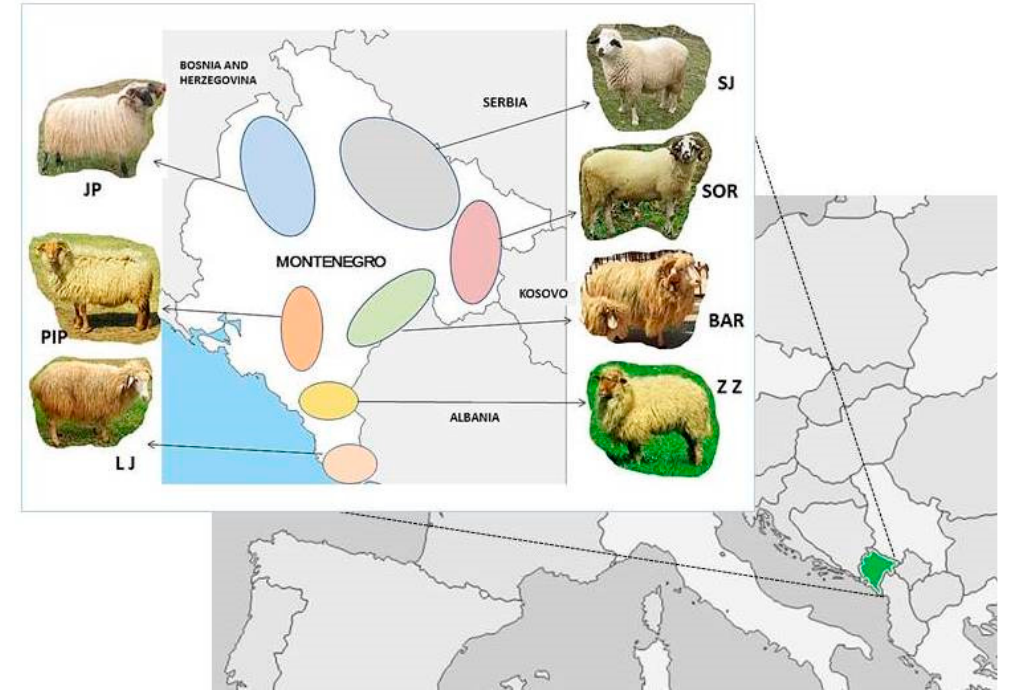
Figure 1. Locations of the breeding area of the Montenegrin sheep breeds. Ljaba (LJ) is a very small sheep, usually white colored with sporadically yellow spotted face and legs, reared in the Southeast region, which has Mediterranean climate conditions. Piperska zuja (PIP) is mostly reared in the central part of Montenegro; this breed